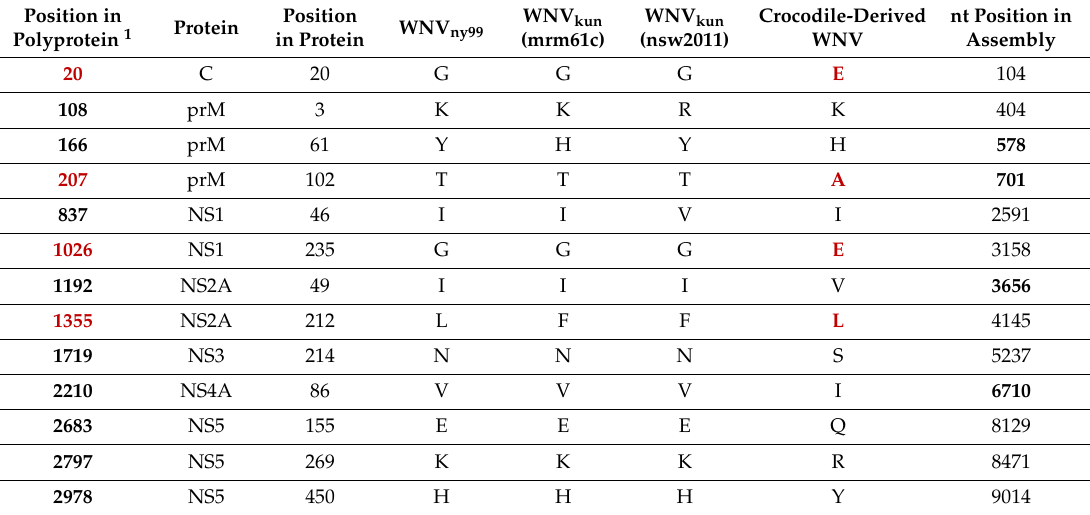
Table 2. Comparison of amino acid sequences between the crocodile-derived WNV RNA and three previously described WNV strains over the 13 amino acid positions that di ff ered between WNV KUN (strain NSW2011) and the crocodile-derived WNV